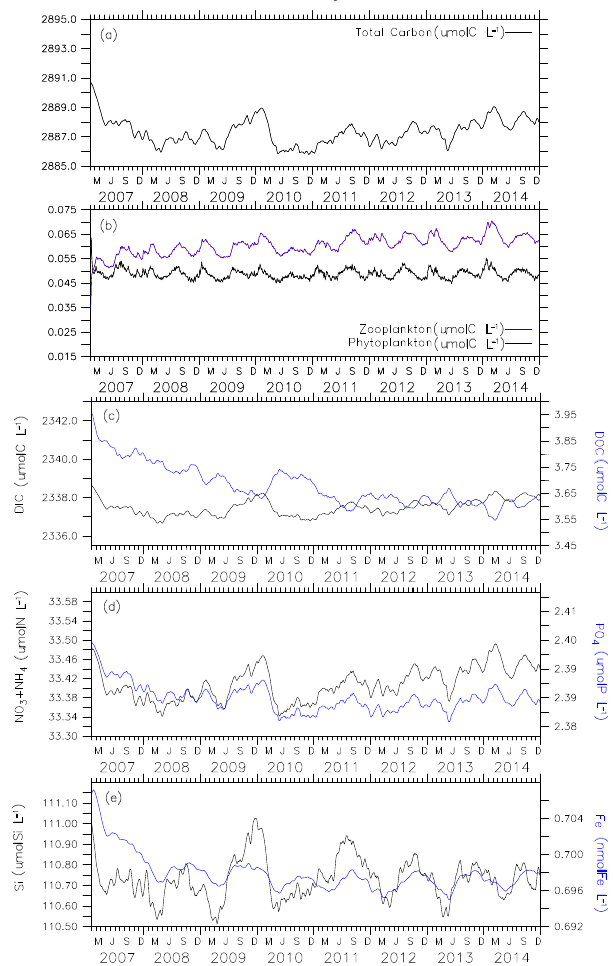
Figure 1. Temporal evolution of total carbon (a) , plankton (b) , DIC and DOC (c) and nutrient (d, e) content averaged over the whole three-dimensional INDO12BIO